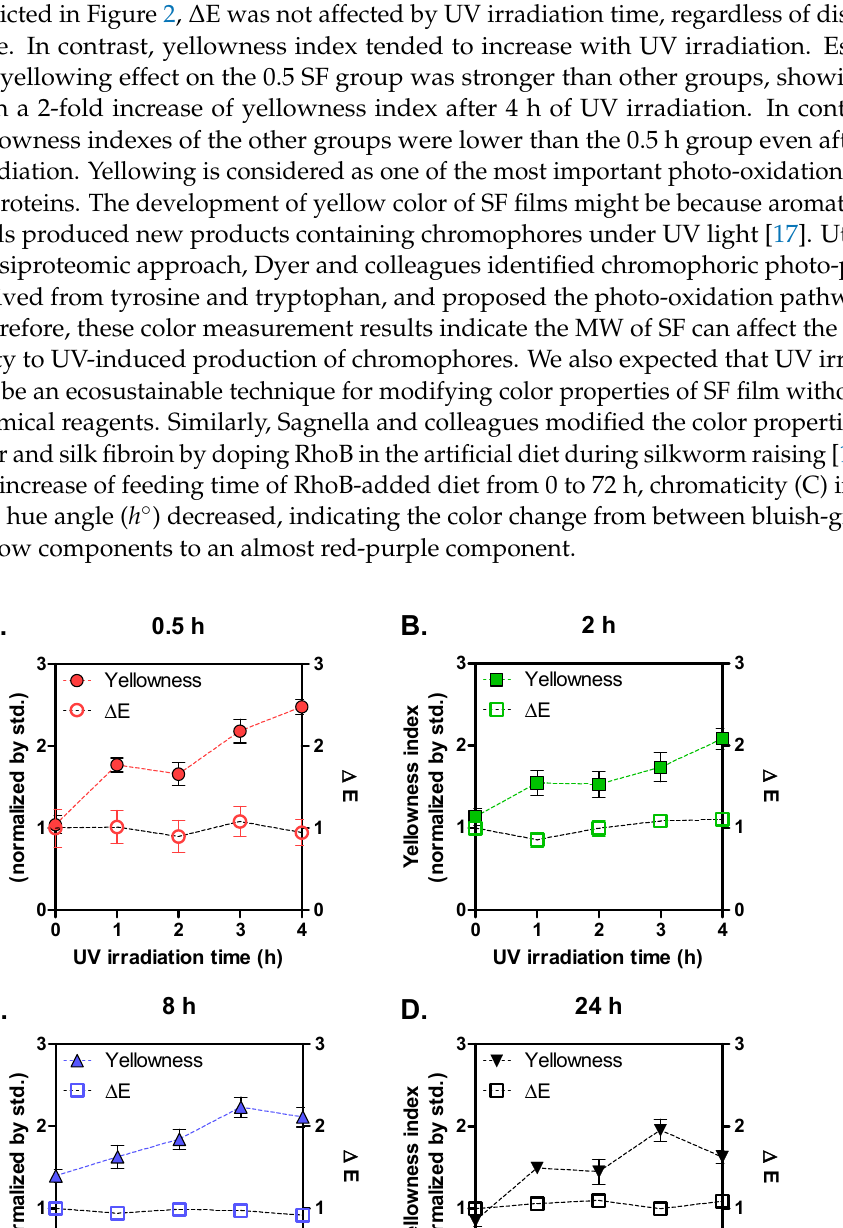
Figure 2. Yellowness and total color differences ( Δ E) of UV-irradiated SF films (1–4 h) prepared four SF solutions that were dissolved for different times ( A : 0.5 h; B : 2 h; C : 8 h; D : 24 h) (n > 10;